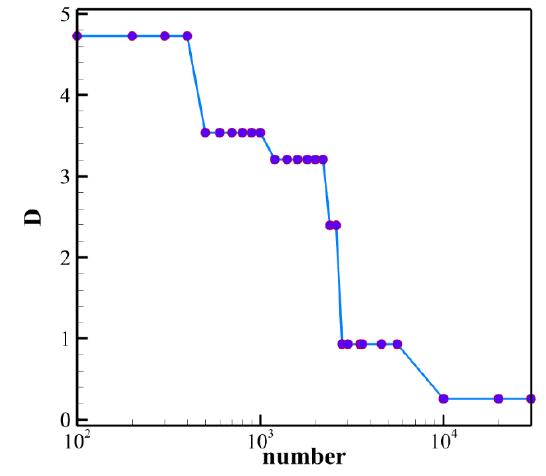
Figure 5. Influence of sample number on accuracy.